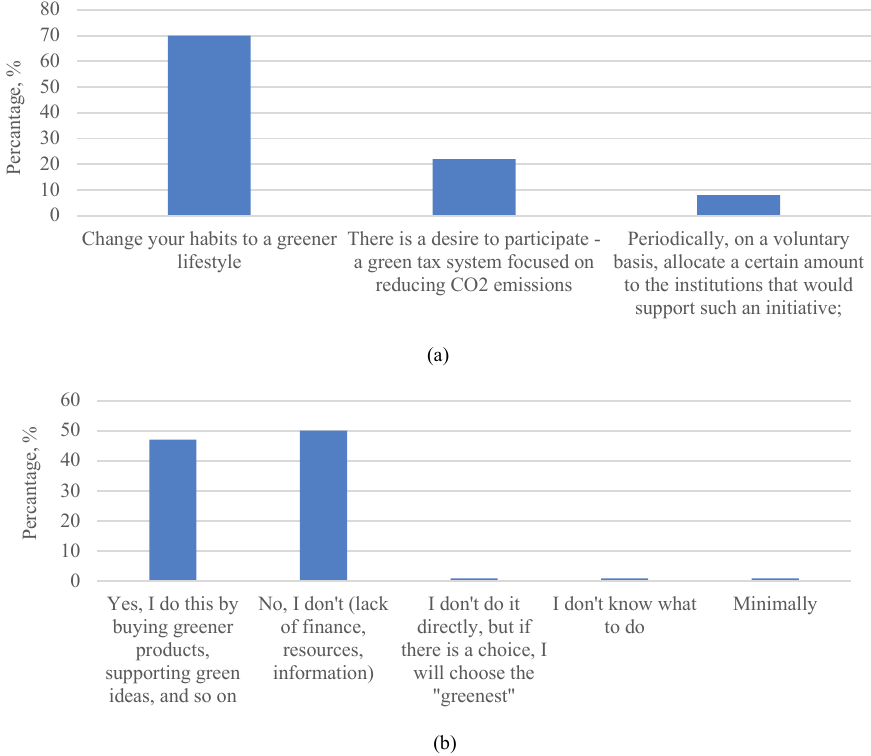
Fig. 8. Questions: a) What actions would You be willing to take to reduce the negative impact of CO 2 emissions? b) Are You currently doing anything to reduce CO 2 emissions